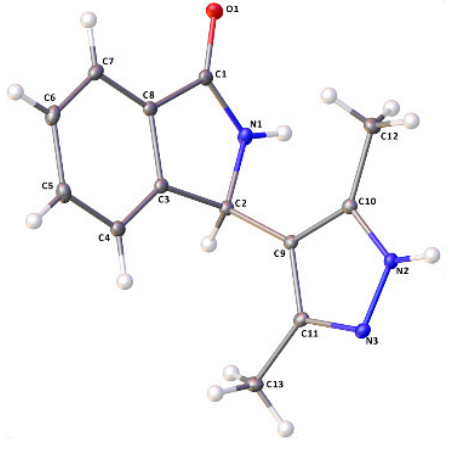
Figure 4. ORTEP drawings for compound (+)- 6 (CCDC 2246867).